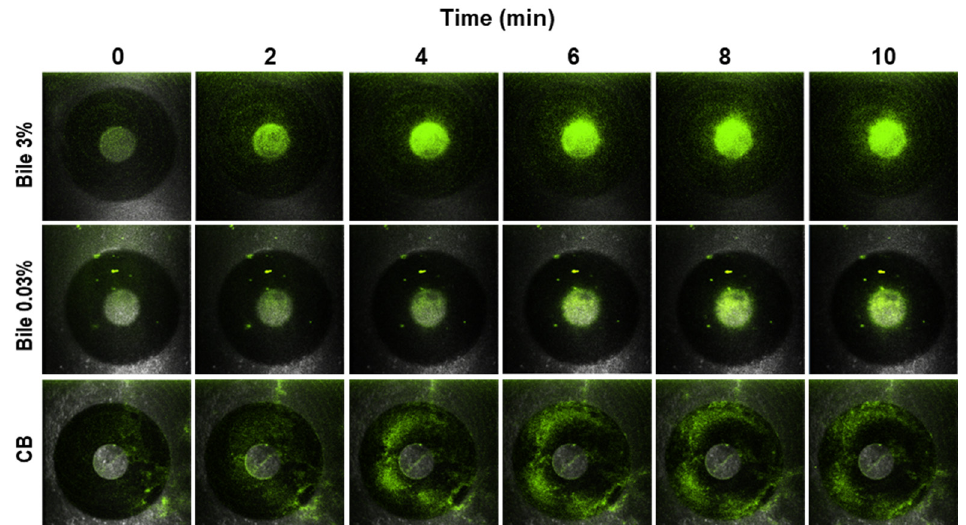
Figure 3. Chemotaxis of green fluorescent protein (GFP)-labeled P. aeruginosa PAO1 toward bovine bile using cystic fibrosis-derived bronchial epithelial (CFBE) cells. Confocal microscopy images (10 × ) of the chemoattraction of GFP-labeled PAO1 toward 0.03% and 3% ( w/v ) bovine bile on CFBE cells at times 0–10 min (two top panels). Chemotaxis buffer (CB) with no response is shown for contrast (below panel). PAO1 is attracted to bovine bile in an intact respiratory CFBE cell model, as illustrated in Figure 1.